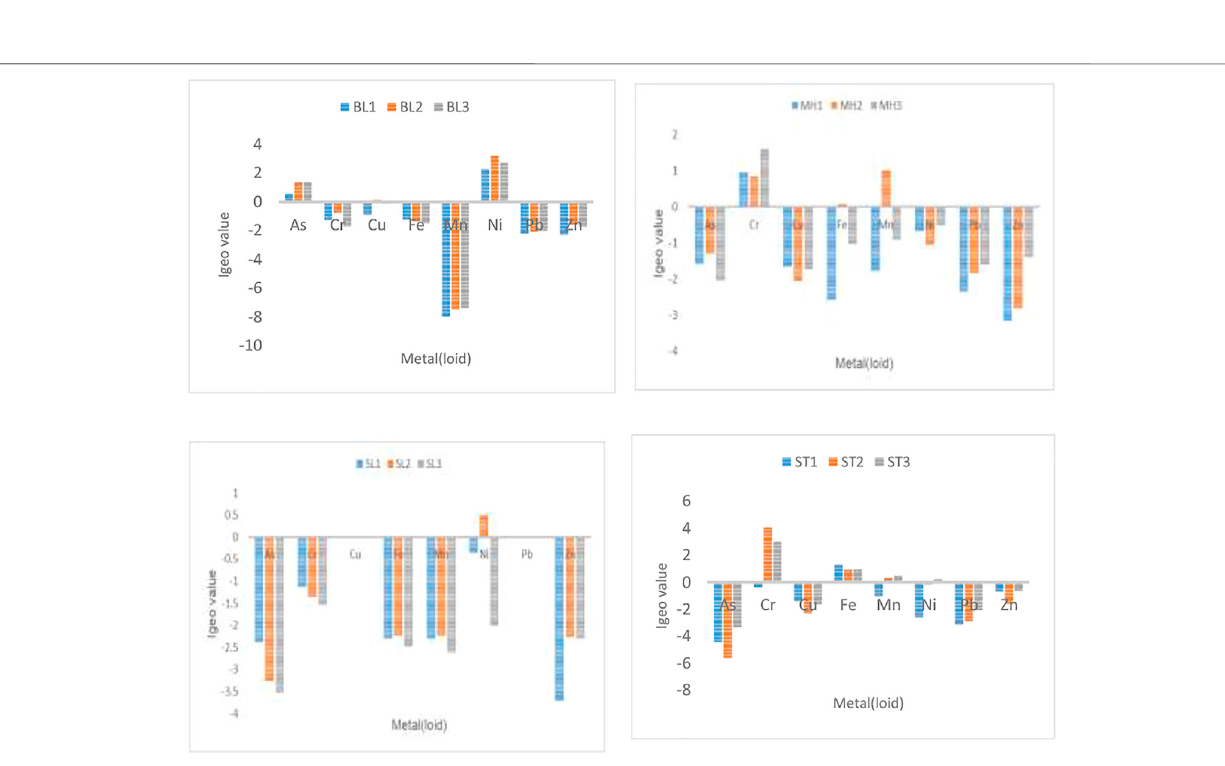
Frontiers in Environmental Science |